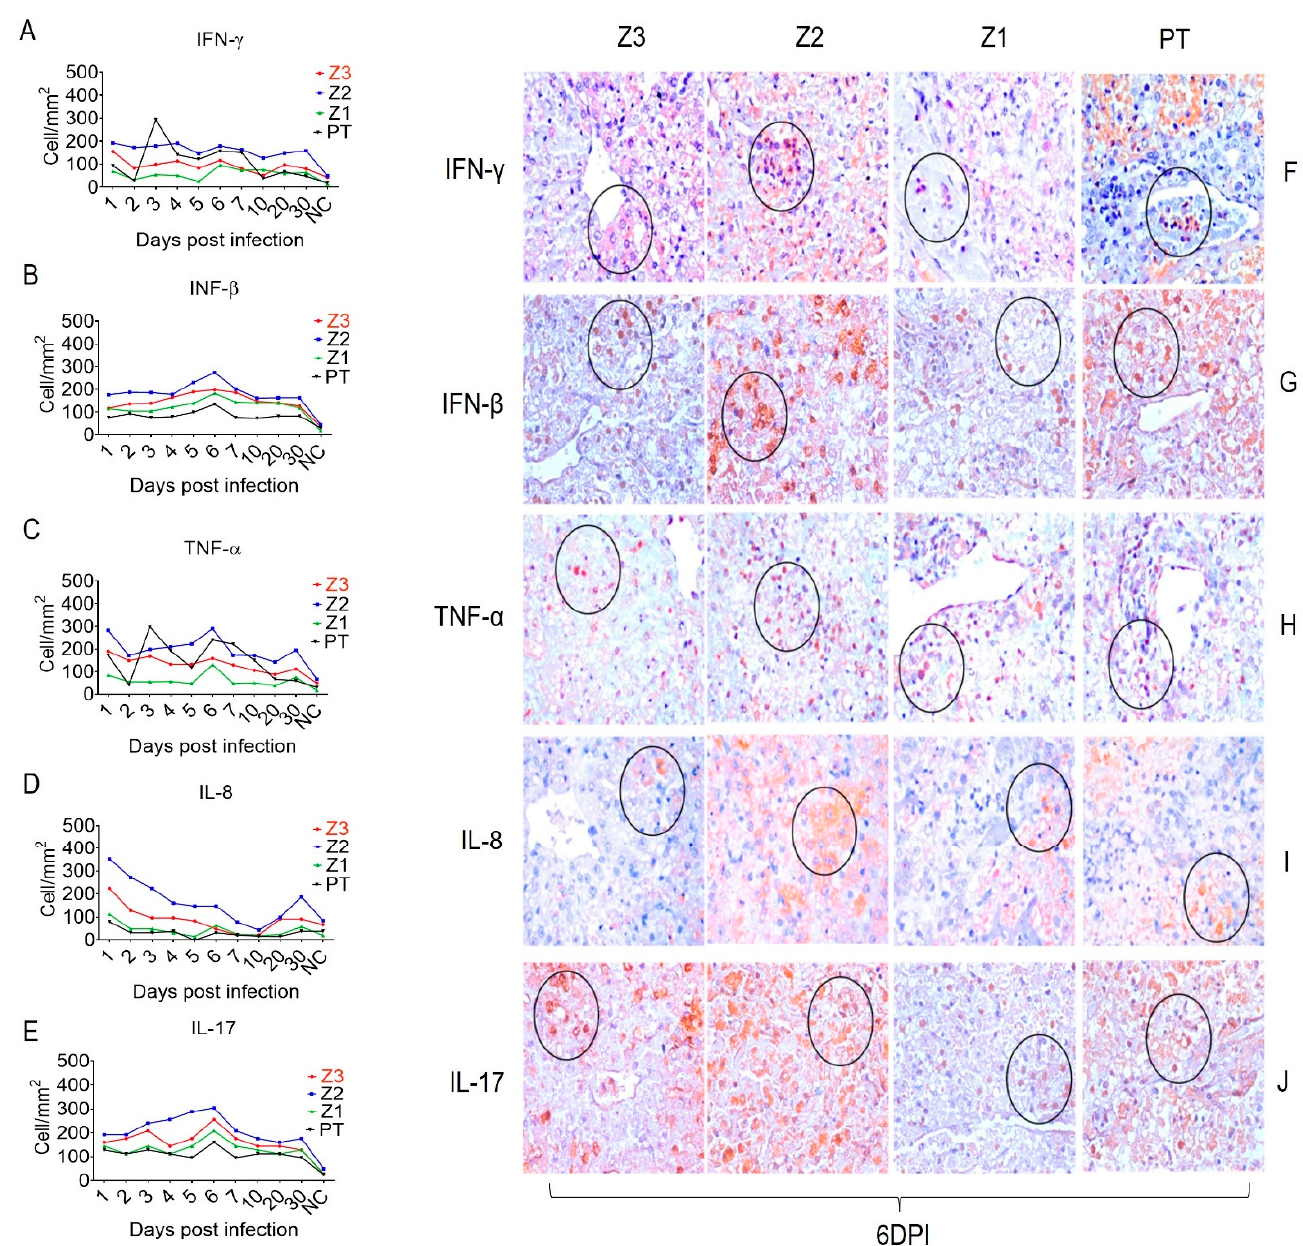
Figure 5. Quantitative immunohistochemical analysis of selected pro- inflammatory cytokines in zones Z3, Z2, Z1 and PT in the hepatic parenchyma of squirrel monkeys ( Saimiri spp.) infected with YFV. Circles represent areas expressing higher immunostaining cells in different hepatic areas. ( A ) IFN- γ expression. ( F )-Immunostaining for IFN- γ in hepatocytes (F-Z3), and in inflammatory infiltrate (F-Z2), (F-Z1), (F-PT). ( B ) Expression of IFN- β . ( G ) Immunostaining for IFN- β in hepatocytes (F-Z3), (F-Z2) in inflammatory infiltrate, (F-Z1) in hepatocytes, (F-PT). ( C ) Expression of TNF- α . ( H ) Immunostaining for TNF- α in inflammatory infiltrate (F-Z3), (F-Z2), (F-Z1), (F-PT). ( D ) Expression of IL-8. ( I ) Immunostaining for IL-8 in hepatocytes (F-Z3), (F-Z2), (F-Z1), (F-PT). ( E ) Expression of IL-17. ( J ) Immunostaining for IL-17 in hepatocytes (J-Z3), (J-Z2), (J-Z1), (J-PT) in 6 dpi.